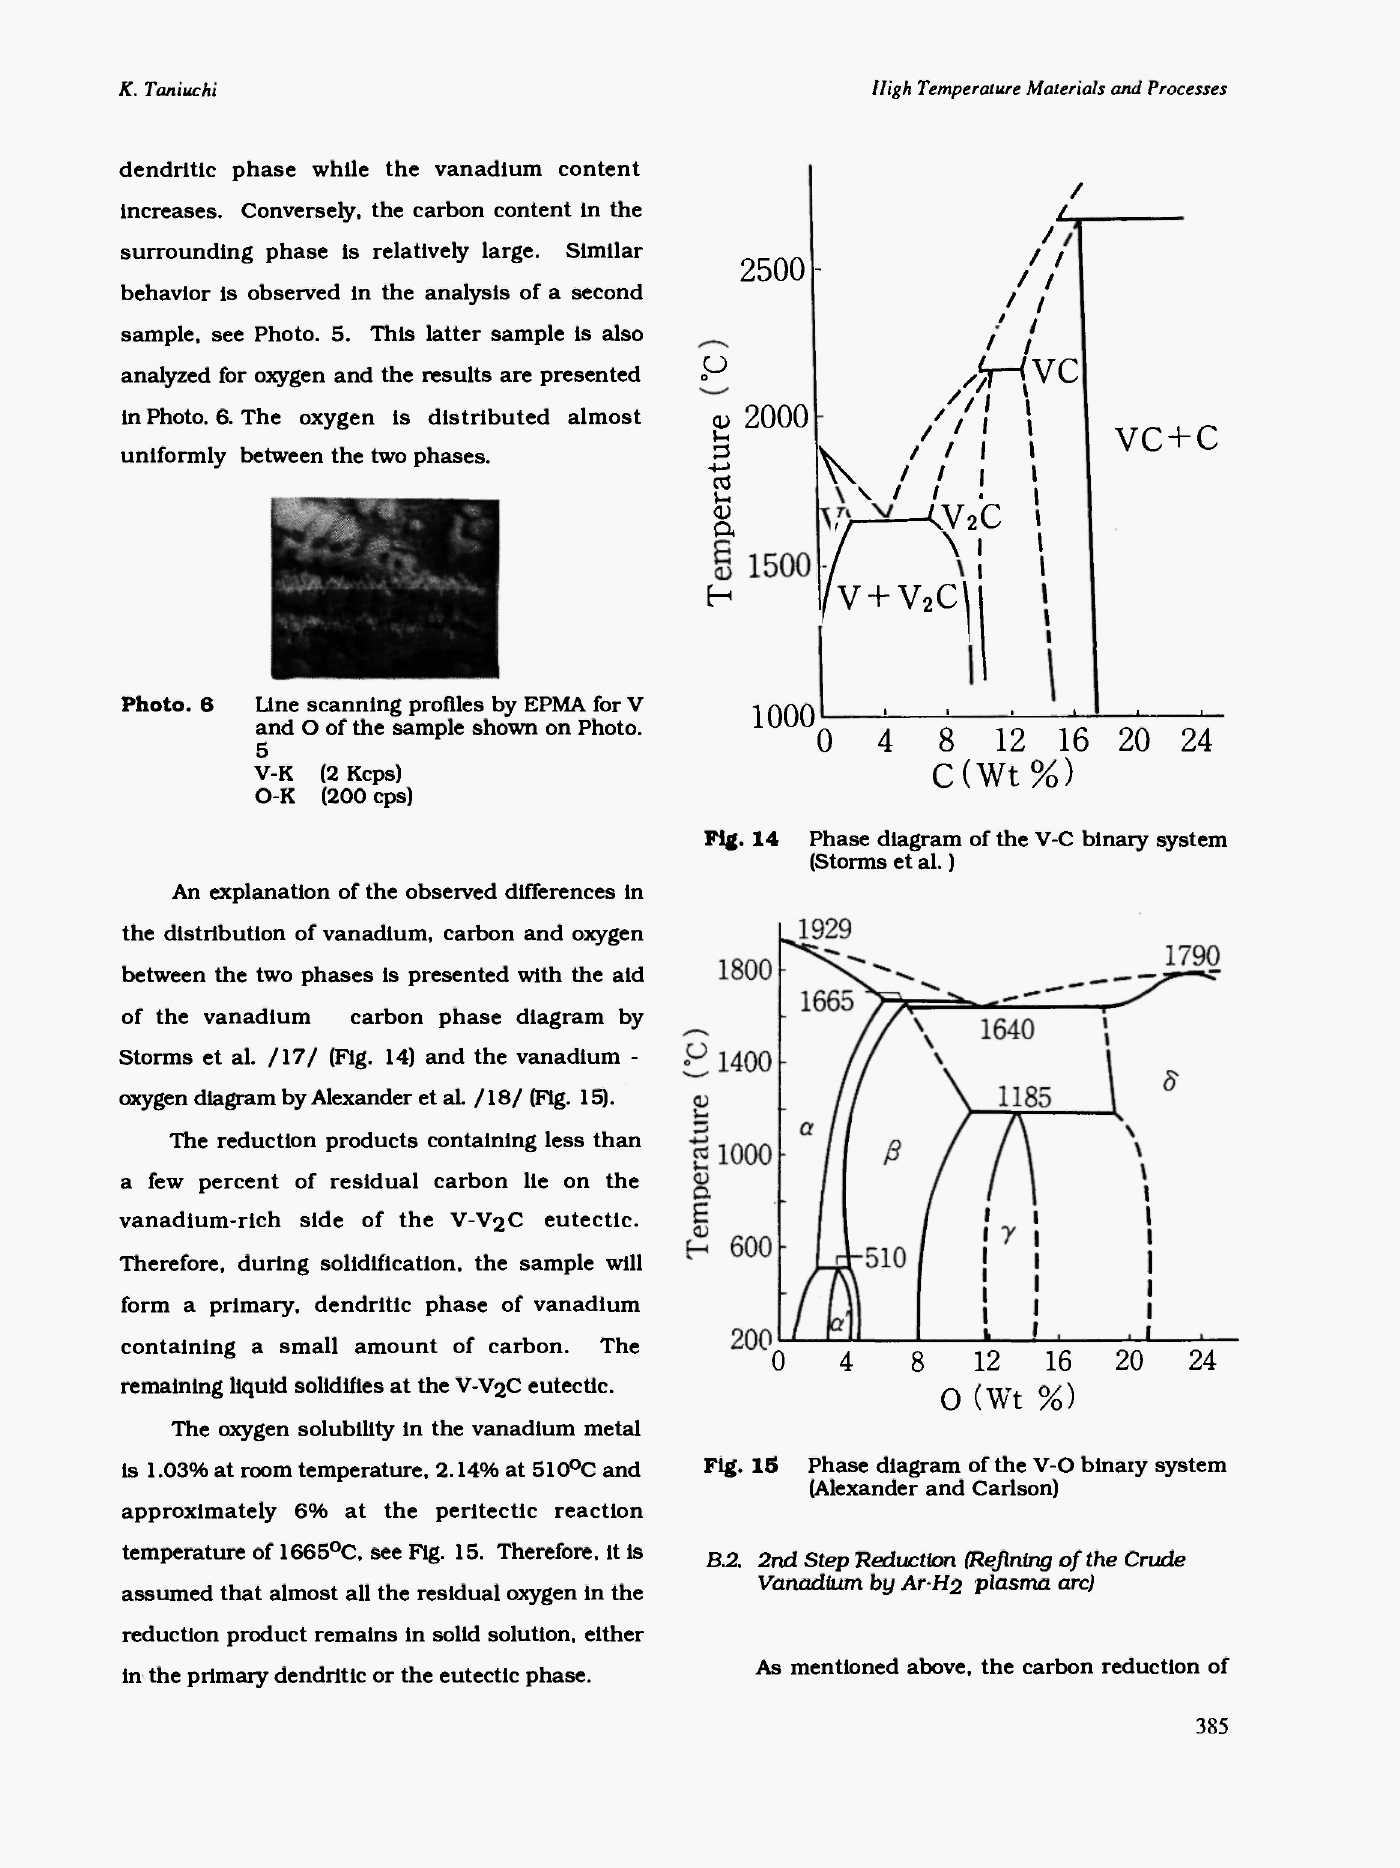
Fig. 15 Phase diagram of the V-O binaiy system (Alexander and